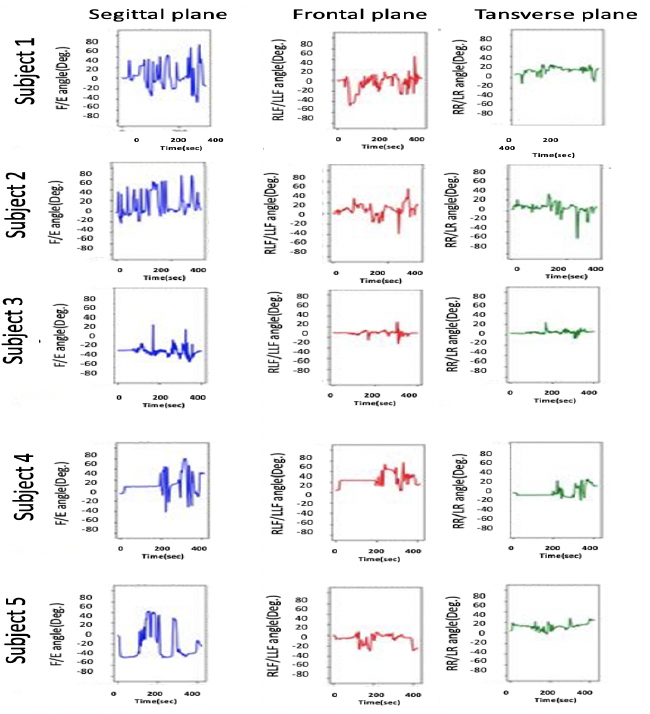
Figure 17. Head movement for children with CP.